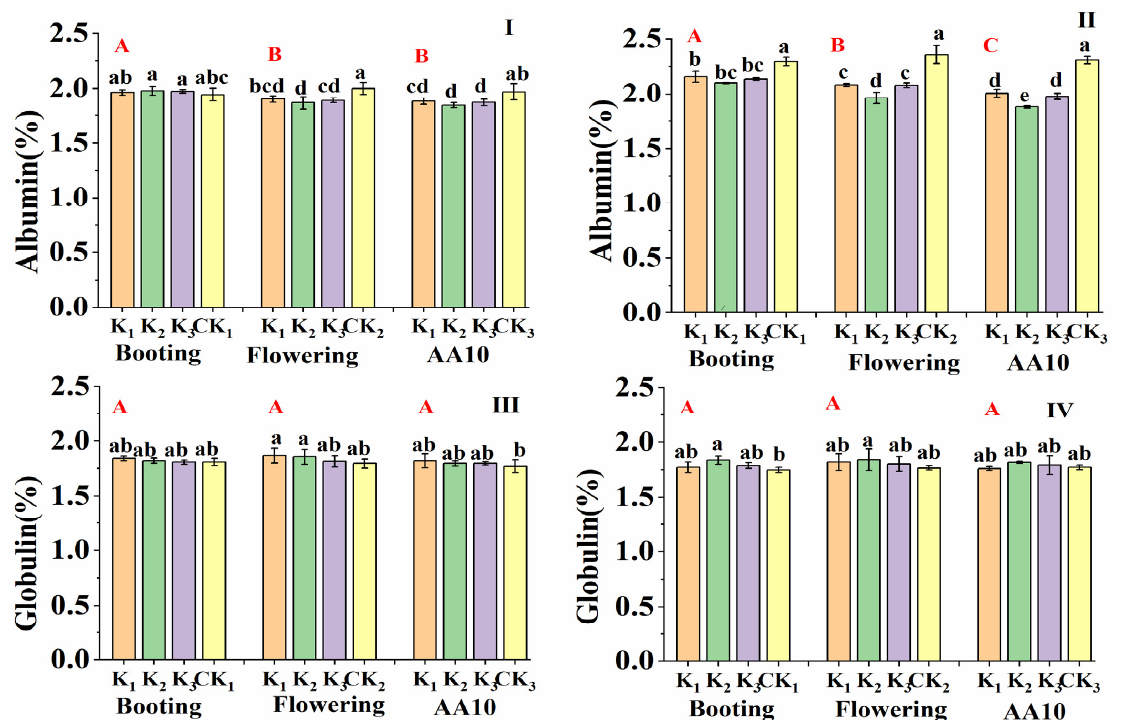
Figure 5. Effects of potassium foliar application on the Albumin and Globulin of wheat with Xinong 20 and Xiaoyan 22. I and III represented Xinong 20, and II and IV represented Xiaoyan 22. Booting (BBCH 48), Anthesis (BBCH 65), and AA10 (BBCH 71): Potassium fertilizer foliar sprayed at booting stage, anthesis stages, and 10 days post anthesis, respectively. K 1 , K 2 , and K 3 represented the application concentration of potassium 30, 60, and 90 mmol L − 1 , respectively. CK: Same amount of deionized water was sprayed on the leaves. Vertical bars represent the mean values ± standard deviation (n = 3). Different lower-case letters indicate a significant difference ( p < 0.05). Different capital letters indicate a significant difference ( p < 0.05) among different spraying